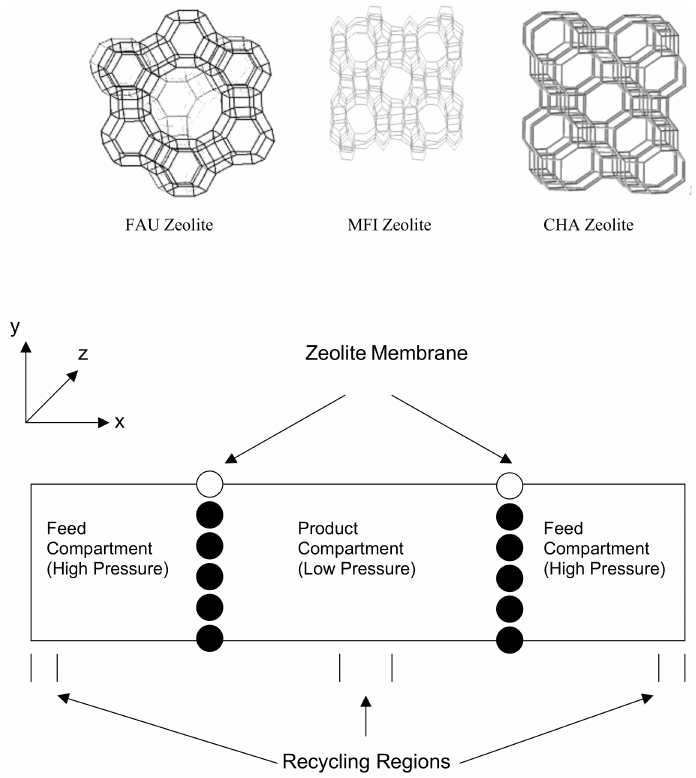
Figure 5. Initial system setup for gas separation simulations and the structure of FAU, MFI and CHA unit